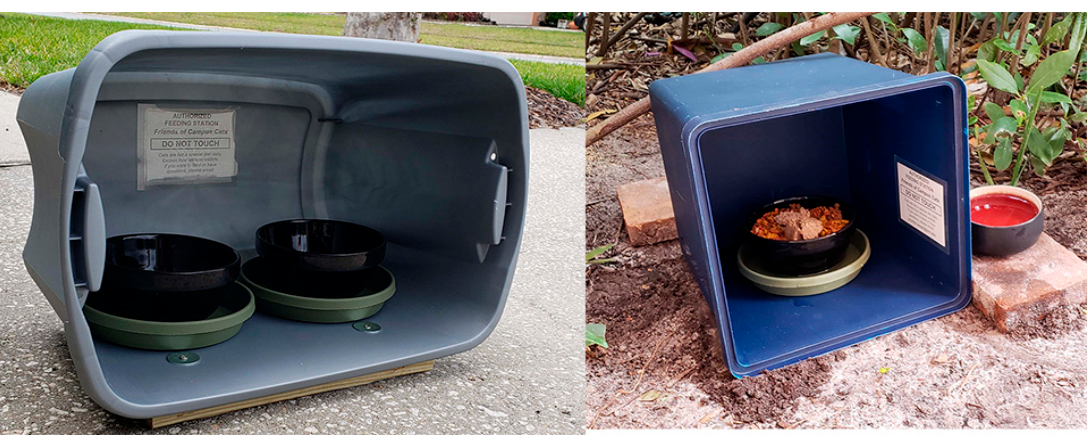
Figure 2. Feeding